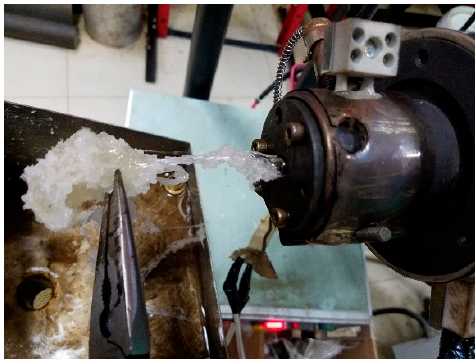
Figure 13. Micro-tube formation under 15,000 Pa.